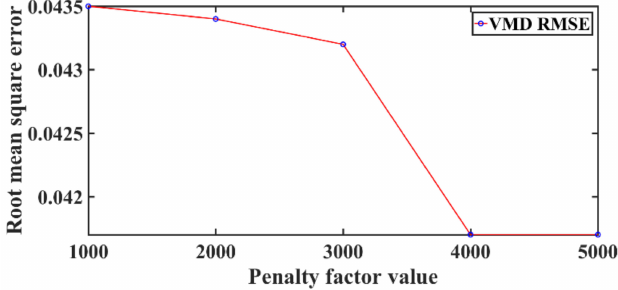
Figure 11. Root-mean-square error under different values of α .